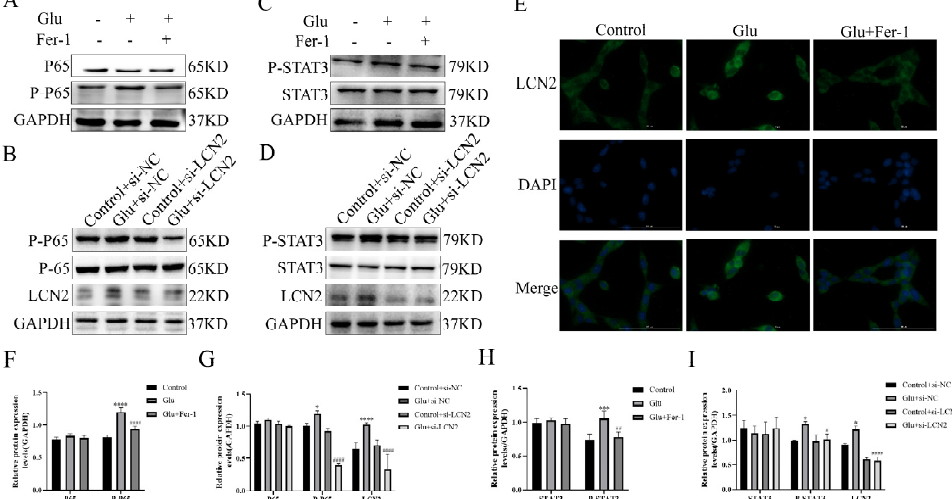
Figure 8. LCN2 regulates the activation of the NF- κ B /STAT3 axis in glutamate-stimulated HT22 cells. ( A – D , F – I ) Western blotting was used to detect the protein expression of P-P65, P65, STAT3, P-STAT3, LCN2 and GAPDH in different treated HT22 cells. Quantitative analysis of results. Compared with the addition of the si-NC empty carrier group, * p < 0.05, *** p < 0.001, **** p < 0.0001. Compared to the group treated with glutamate stimulation combined with si-NC, # p < 0.05, ## p < 0.01, #### p < 0.0001. Two-way ANOVA multiple comparisons were performed between groups. ( E ) Immunofluorescence images of HT22 cells labeled with P65 antibody. Co-staining with DAPI (blue) to show the nucleus. Scale bar = 100 μ m. For all experiments, glutamate: 10 mM, Fer-1: 5 μ M.